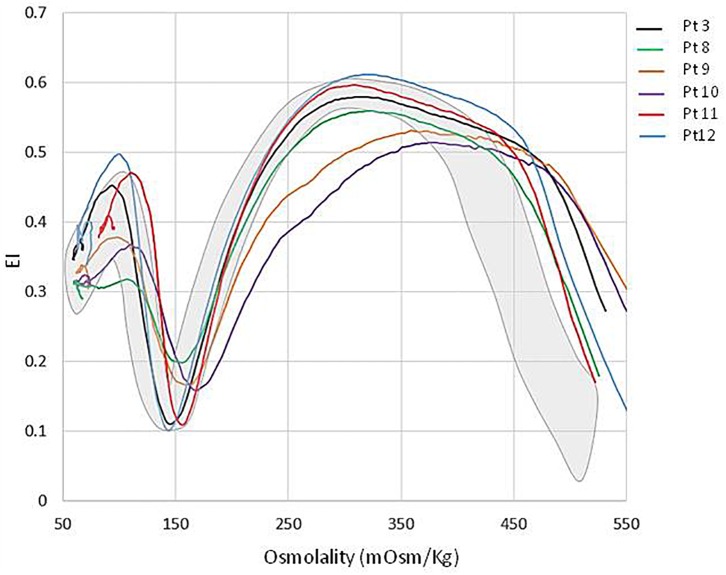
LoRRca Osmoscan curve of 6 GPI deficient patients compared with normal controls (gray area).